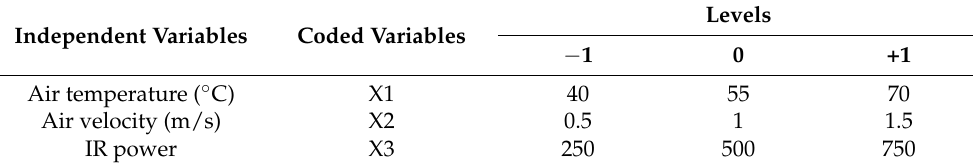
Table 2. Independent variables and their levels.